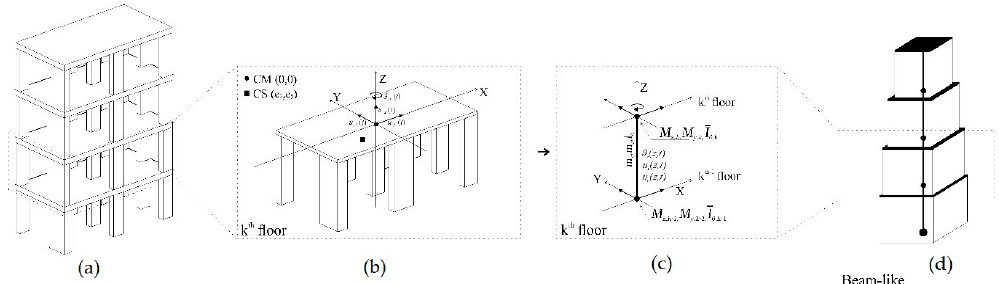
Figure 2. Conceptual representation, starting from ( a ) the 3D structure; ( b ) the generic kth floor (or inter-storey) up to the ( c ) sub-beam element; and the ( d ) the proposed beam-like model.